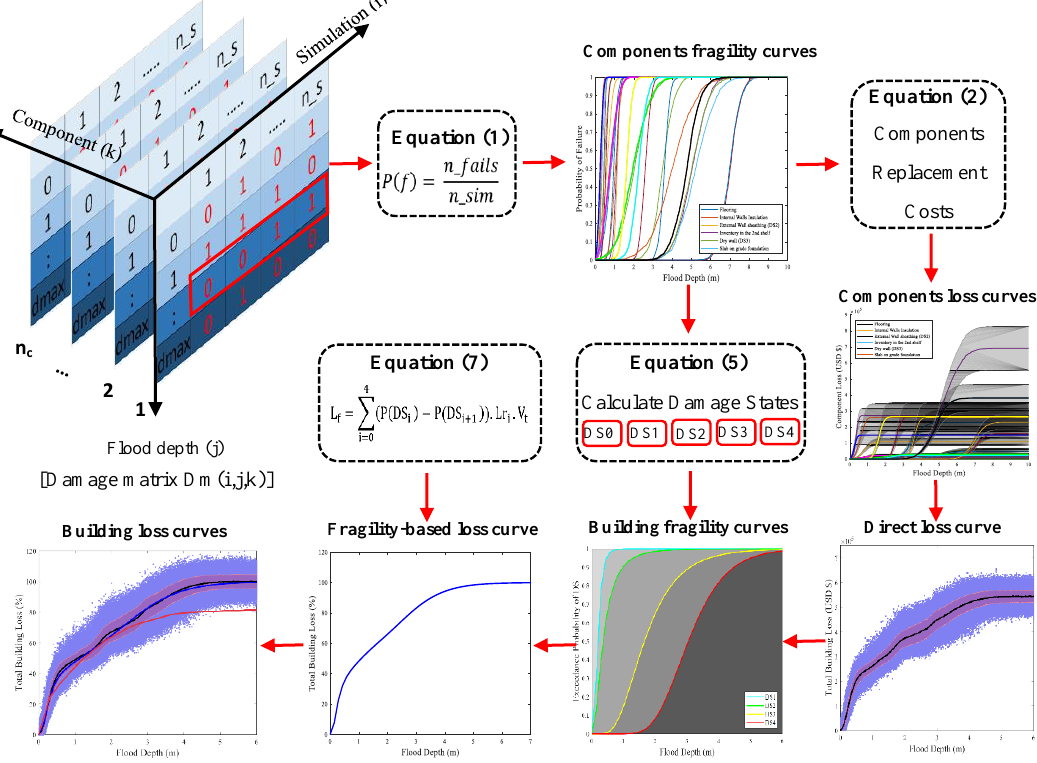
Figure 3. A schematic illustration of the approaches used to develop flood fragility and loss functions.